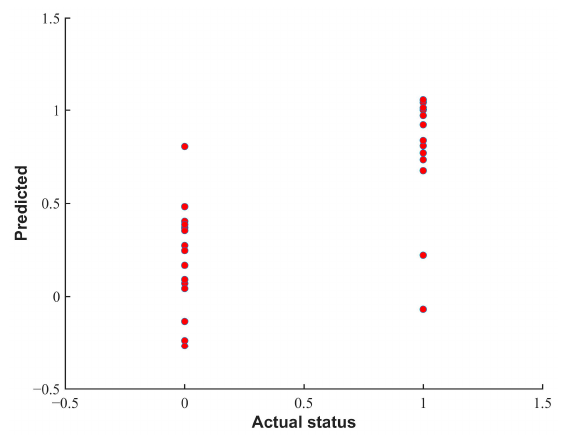
Figure 8. Discriminant results of pork freshness using PLS-DA model.